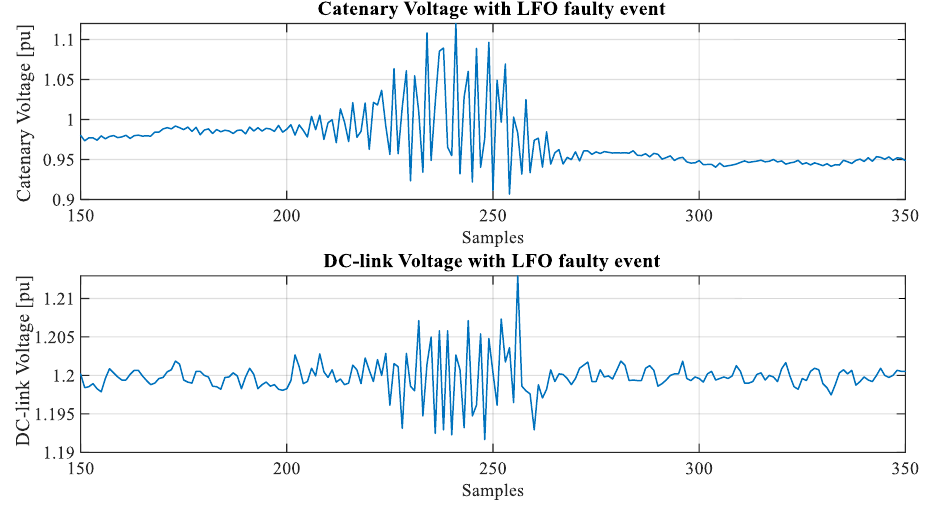
Figure 5. Detail of catenary and DC-Link voltage (pu).